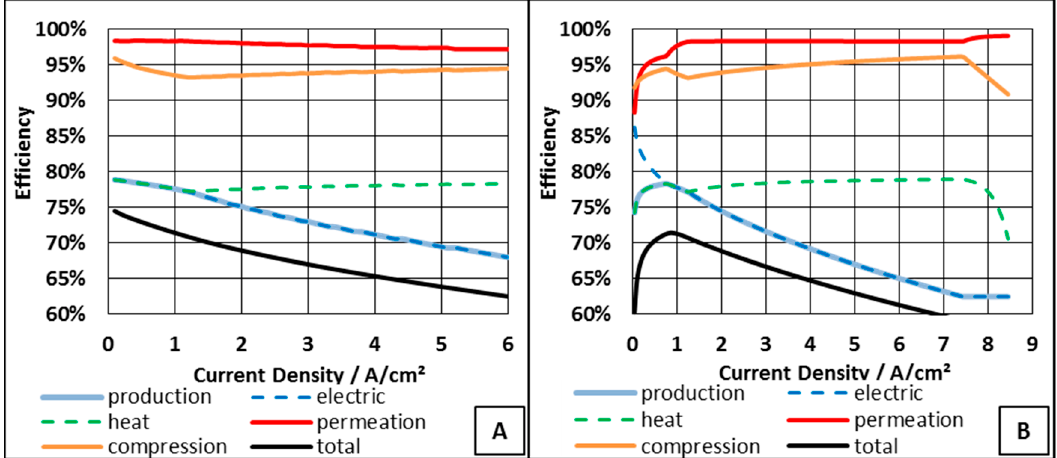
Figure 5. The contribution of the hydrogen production, permeation, and permeation efficiency to the total efficiency is illustrated as a function of current density for the ideal electrolyzer ( A ) and for a voltage-limited N211-based system ( B ). Additionally, the hydrogen production efficiency is separated into electricity (Equation (3)) and heat (Equation (4)). The production efficiency curve symbolizes the minimum of heat or electrical efficiency that can be achieved.